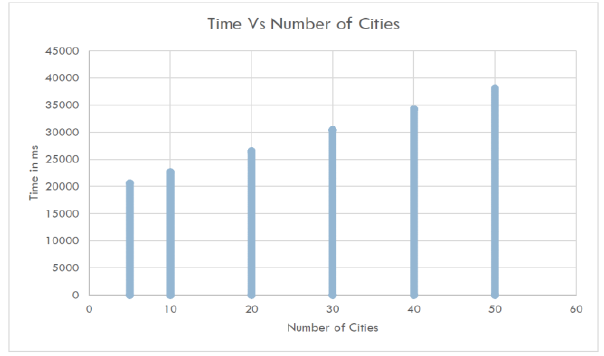
Fig. 9. Time vs Number of cities generated - SA